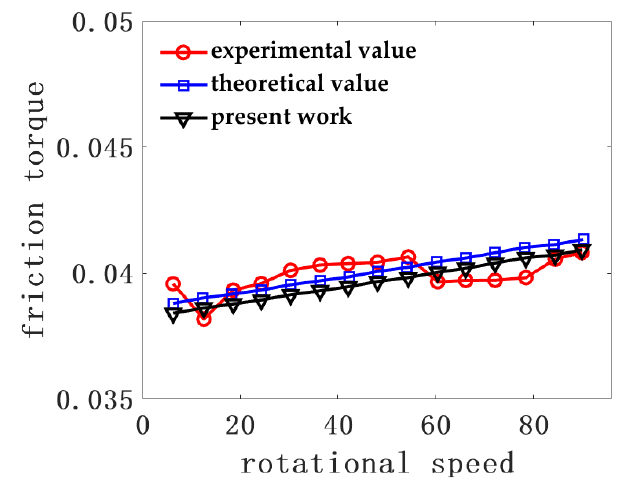
Figure 9. Friction torque.